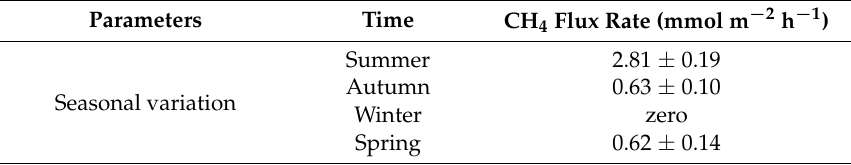
Table 2. The variation characteristics of methane at different time